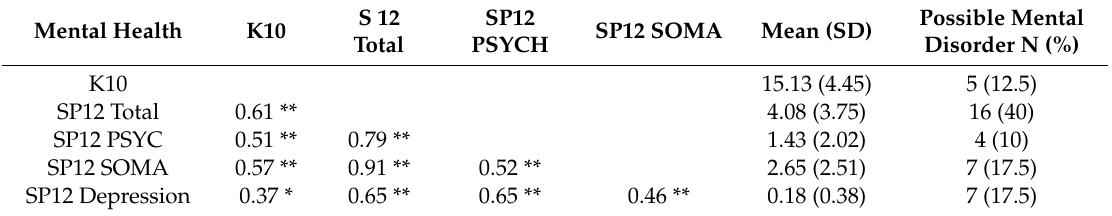
Table 1. Mental health measures: correlations, means, and likelihood of a mental disorder